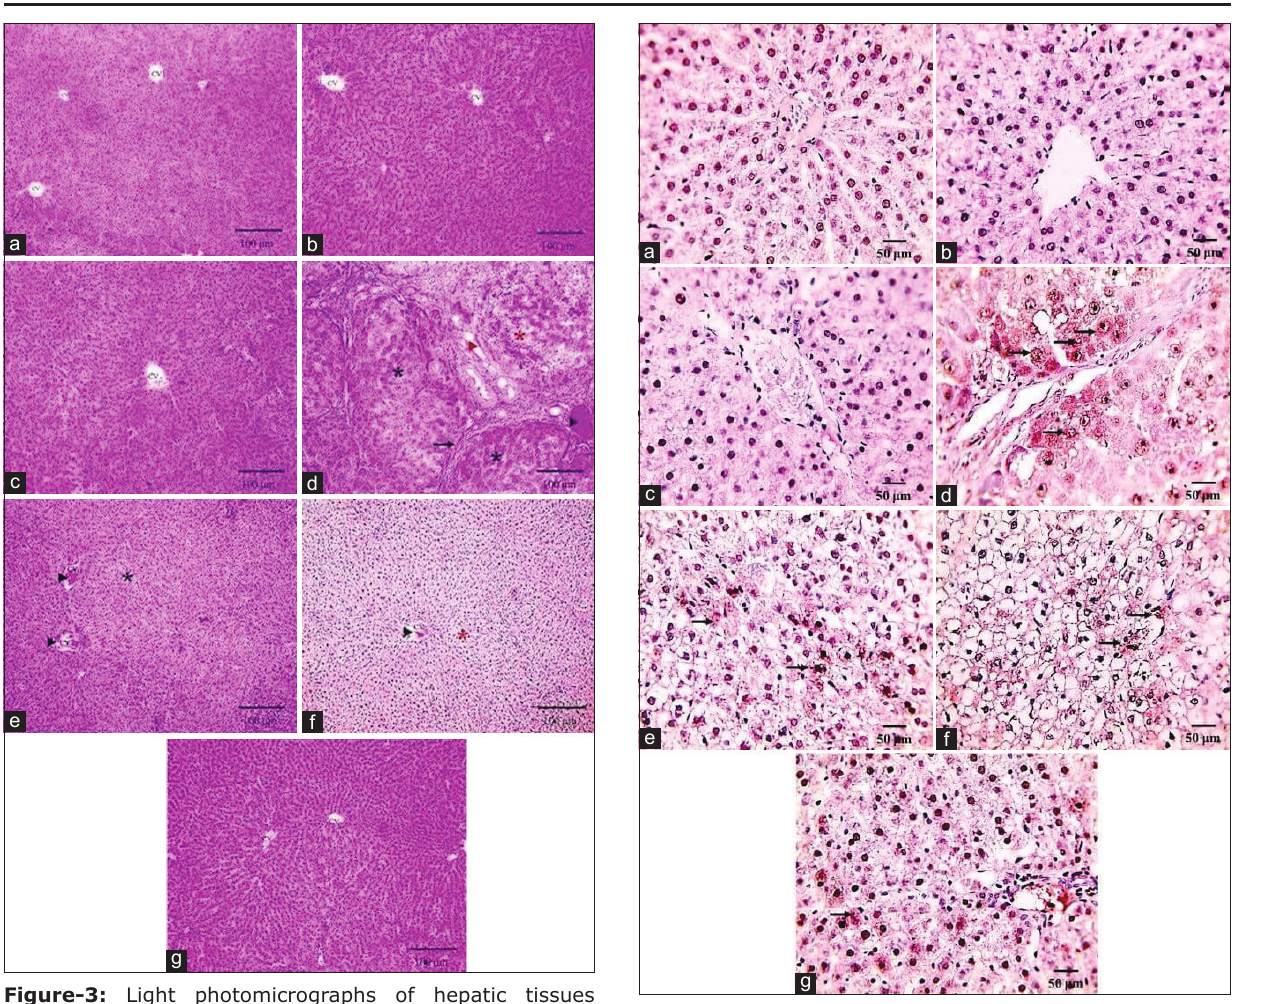
Figure-4: Immunohistochemical staining of rat liver by caspase-3. (a-c) Negative caspase-3 reaction in the liver sections. (d) Strong brown cytoplasmic signal of caspase-3 was observed in the hepatocytes from fipronil (FPN)- intoxicated rats (black arrow). (e) Moderate cytoplasmic signal of caspase-3 marker. (f) Moderate cytoplasmic signal of caspase-3 marker. (a) Control, (b) sitagliptin (Sit), (c) losartan (LOS), (d) FPN, (e) Sit-FPN, (f) LOS-FPN, (g) Sit-LOS-FPN scale bar =50 µ m.